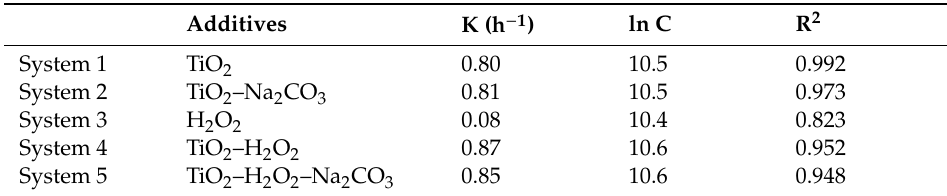
Figure 19. Residual molar concentrations of the dye versus the UV irradiation exposure time (logarithmic scale). Table 2. Kinetic results for Systems 1–5.